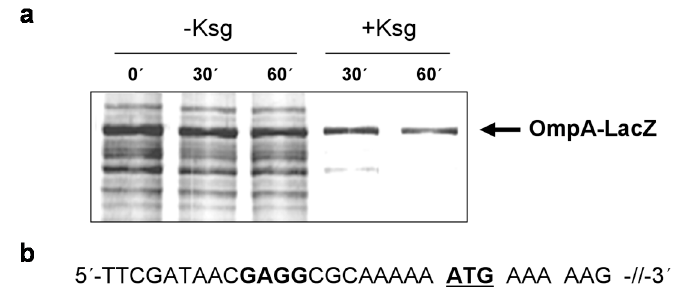
Figure 4. Selective translation of the short-leadered ompA Δ 117 - lacZ mRNA in the presence of Ksg in vivo . ( a ) Pulse labeling of strain MG1655 harboring plasmid pIM17 grown in the absence or in the presence of Ksg. The arrow indicates the position of the fusion protein. ( b ) The sequence of the 5 ′ -UTR and the proximal coding region of the mRNA is given. The AUG start codon is underlined and the SD sequence is given in bold.